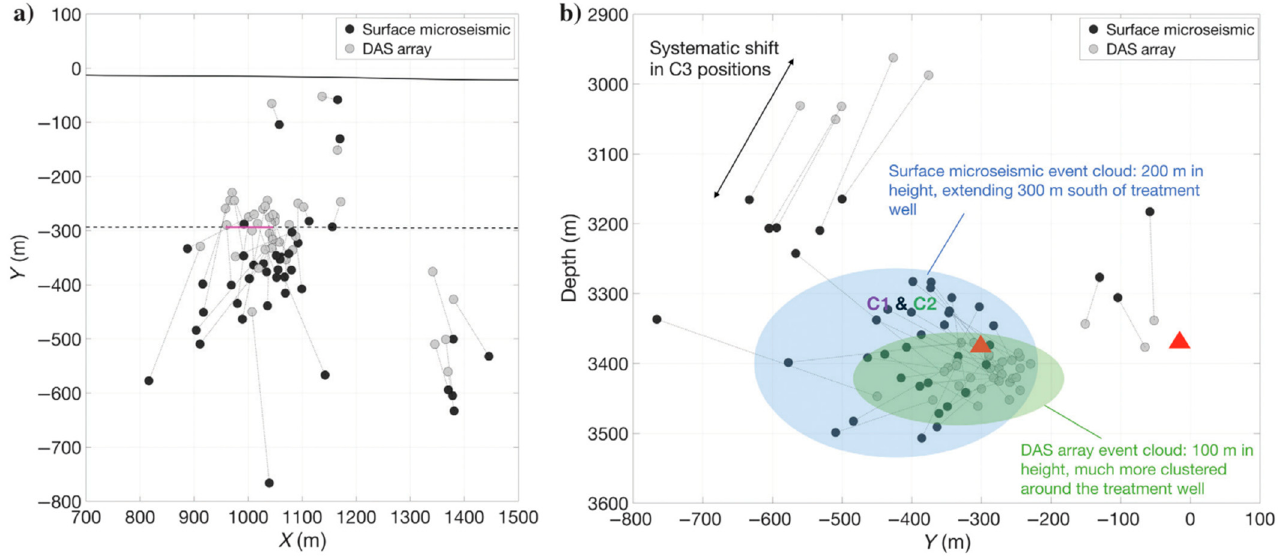
Figure 10. Comparison between event locations derived from two deviated DAS wells (light gray) and surface geophones (black) in map ( a ) and cross-section ( b ) views. DAS locations are generally more clustered around the stimulated well (pink line in a ). In ( b ), red triangles denote the locations of the wells. Figure from Verdon et al. (2020), Geophysics.